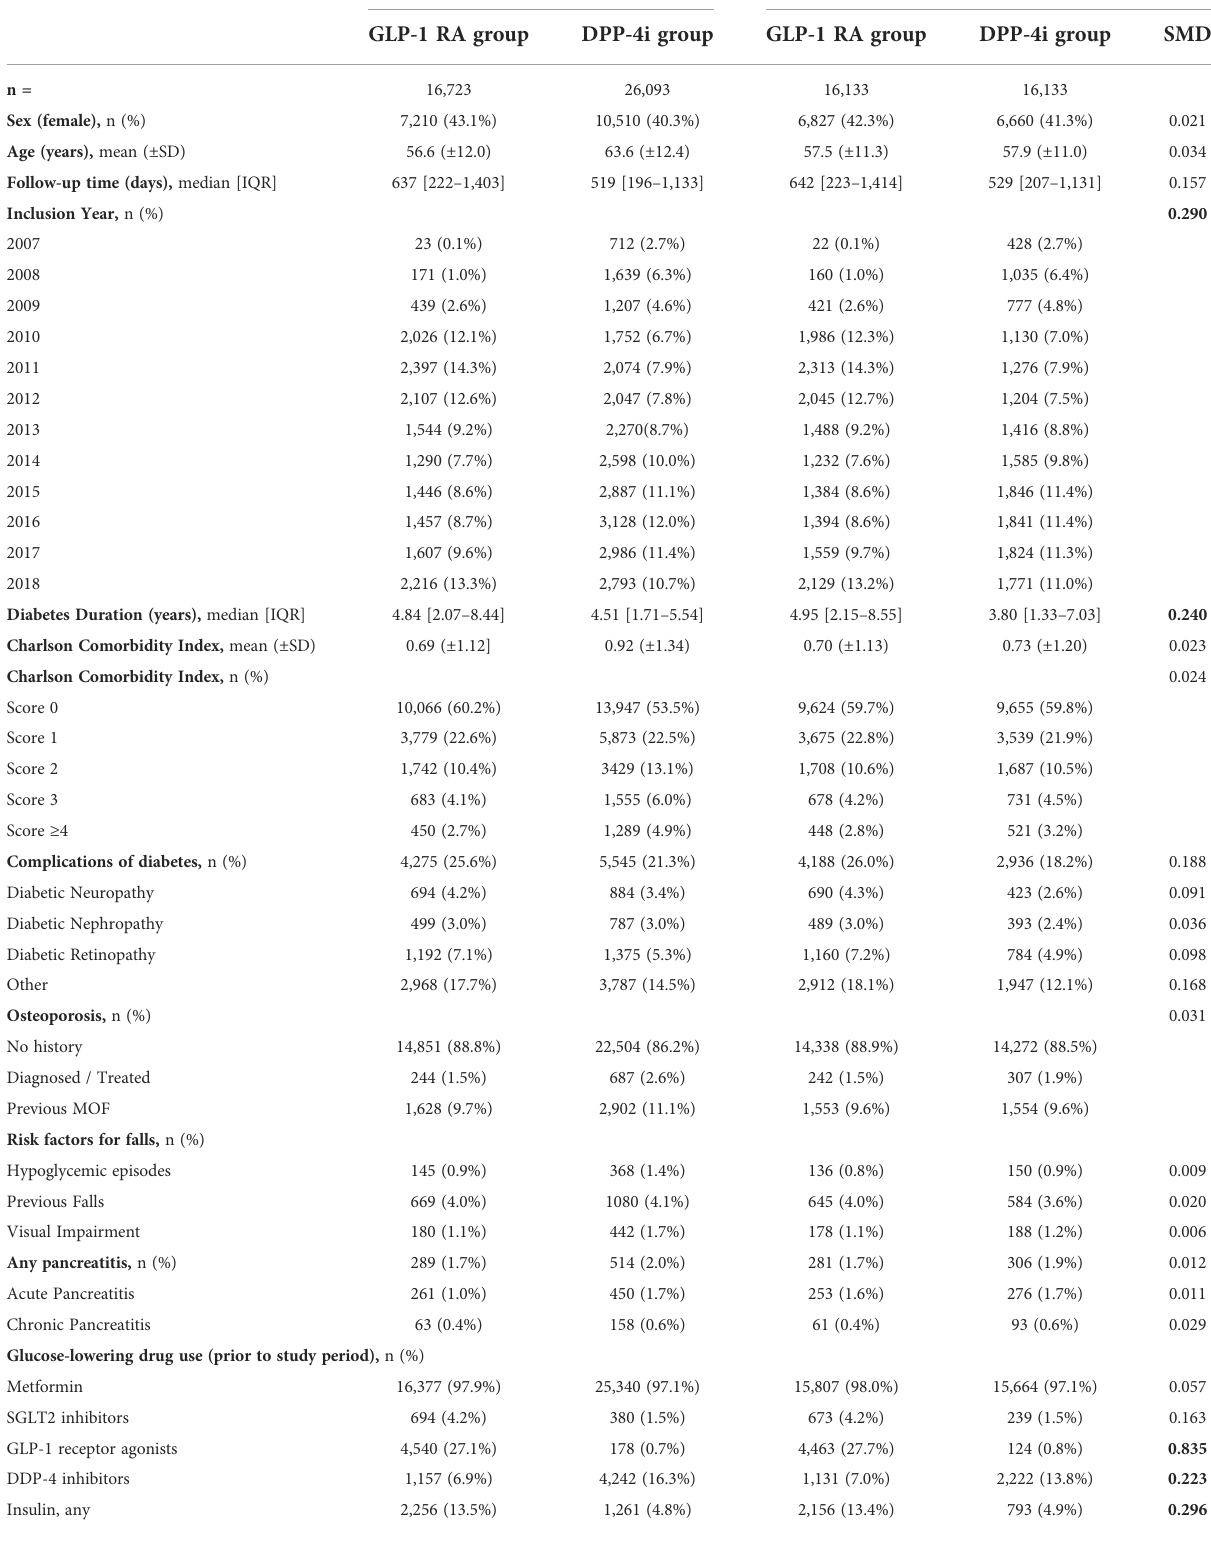
TABLE 1 Baseline characteristics of full and matched